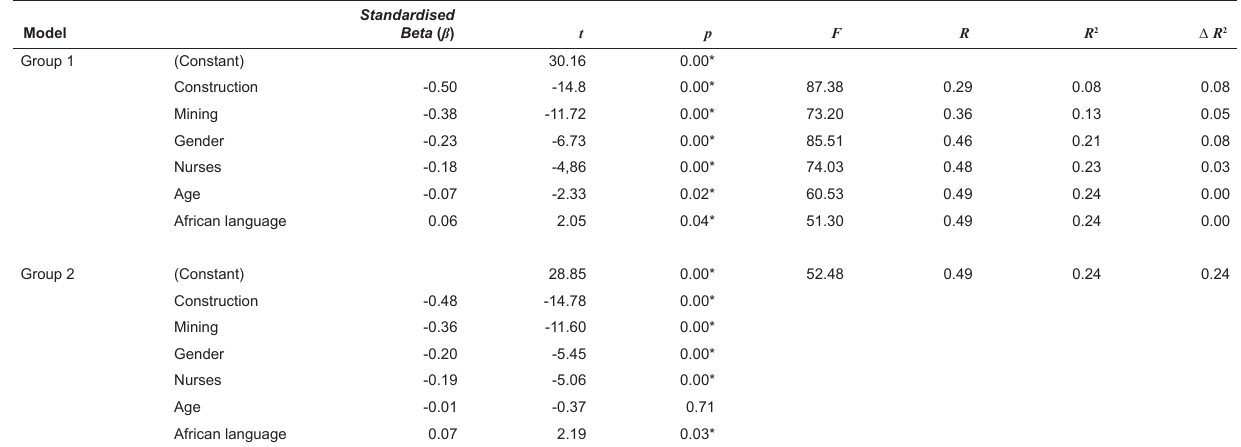
TABLE 2 Multiple regression analysis with negative WHI as dependent variable